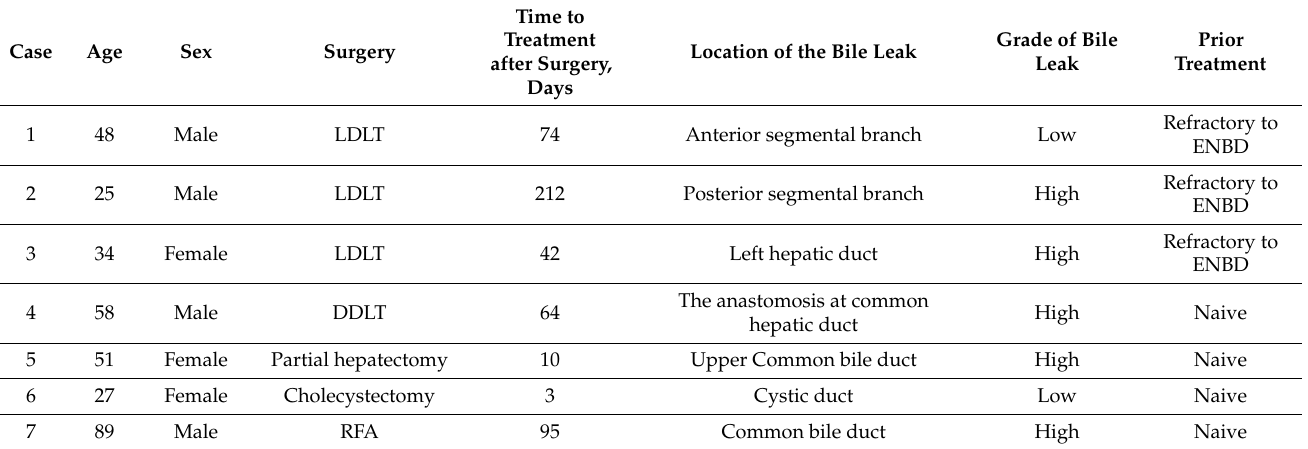
Table 1. Patient